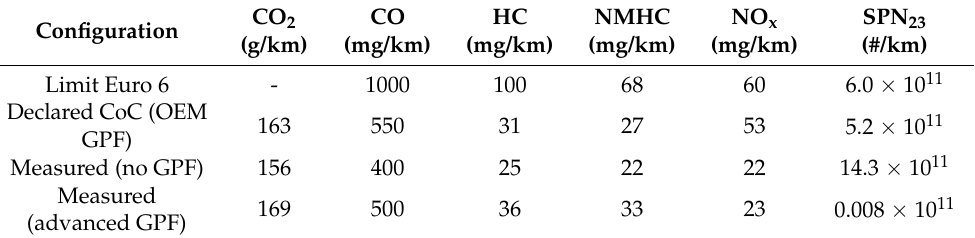
Table 1. Results of the WLTC at 23 ◦ C following the type approval procedures, except for the advanced GPF case where “bad” market fuel was used and no pre-conditioning was done.